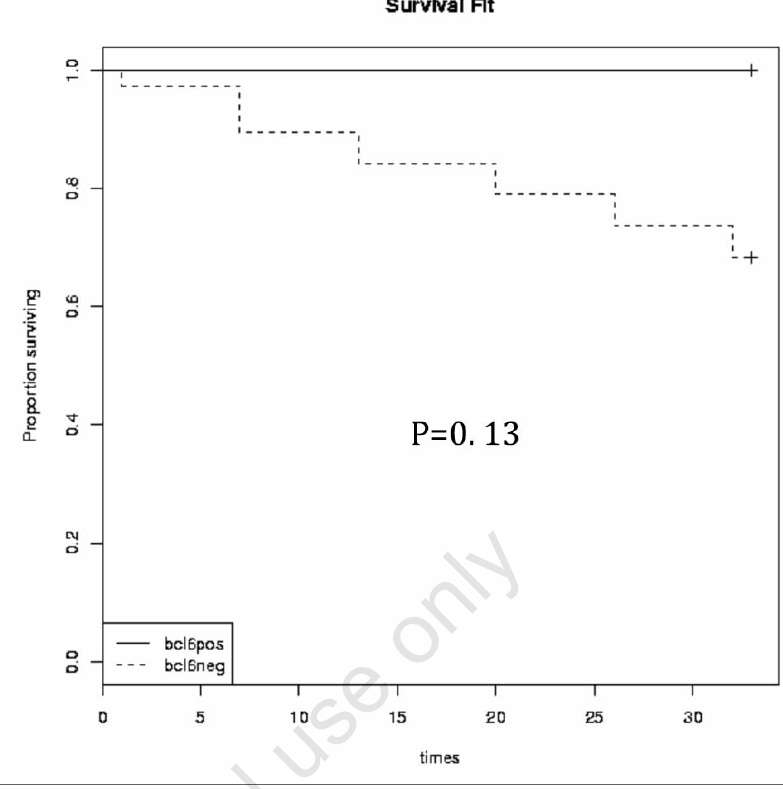
Figure 5. Kaplan-Meier overall survival and disease-free survival times in relation to Bcl-6 protein